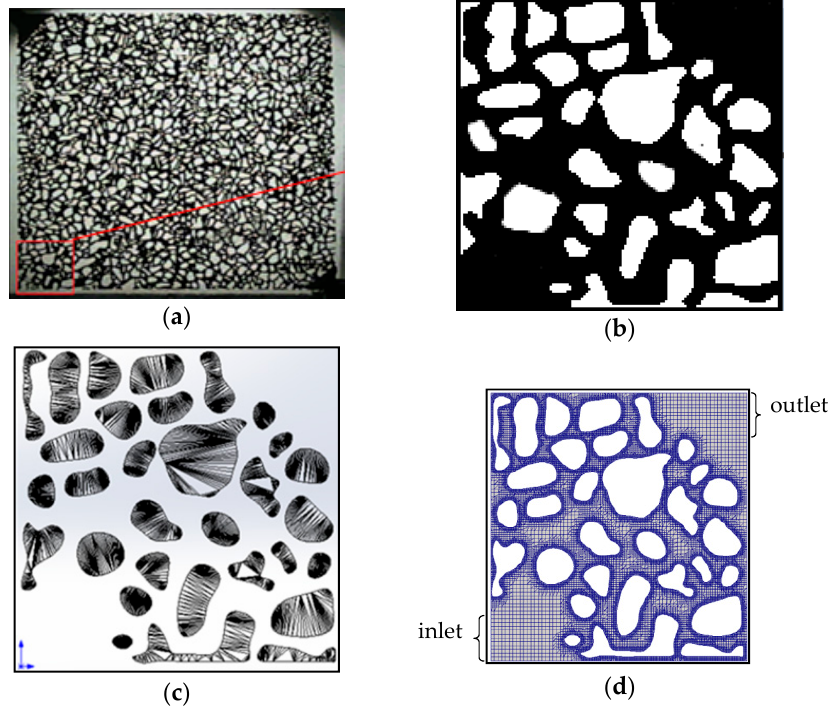
Figure 5. Mesh generation process for the physical simulation model: ( a ) the glass-etched model used in the microexperiment; ( b ) the black and white digitized model; ( c ) STL skeleton grid generated by solidworks; and ( d ) pore meshes generated by OpenFOAM.